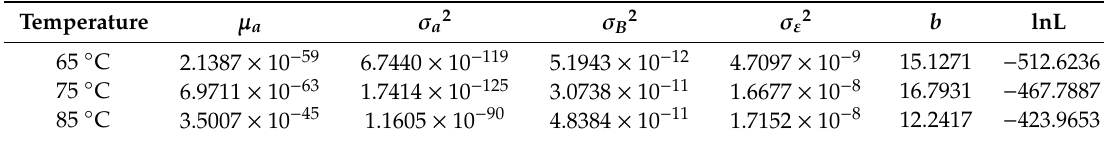
Table 1. Degradation parameters of accelerometers under each accelerated temperature stress.